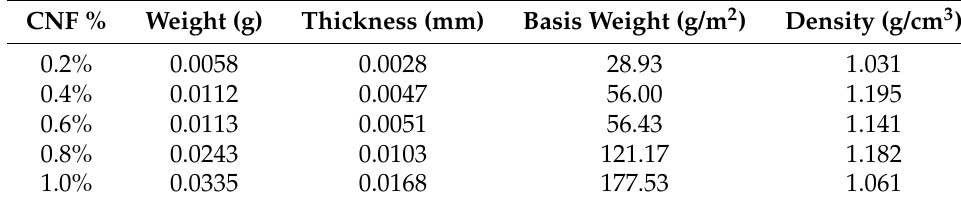
Table 1. Physical properties of CNF-VC film at different CNF concentrations.